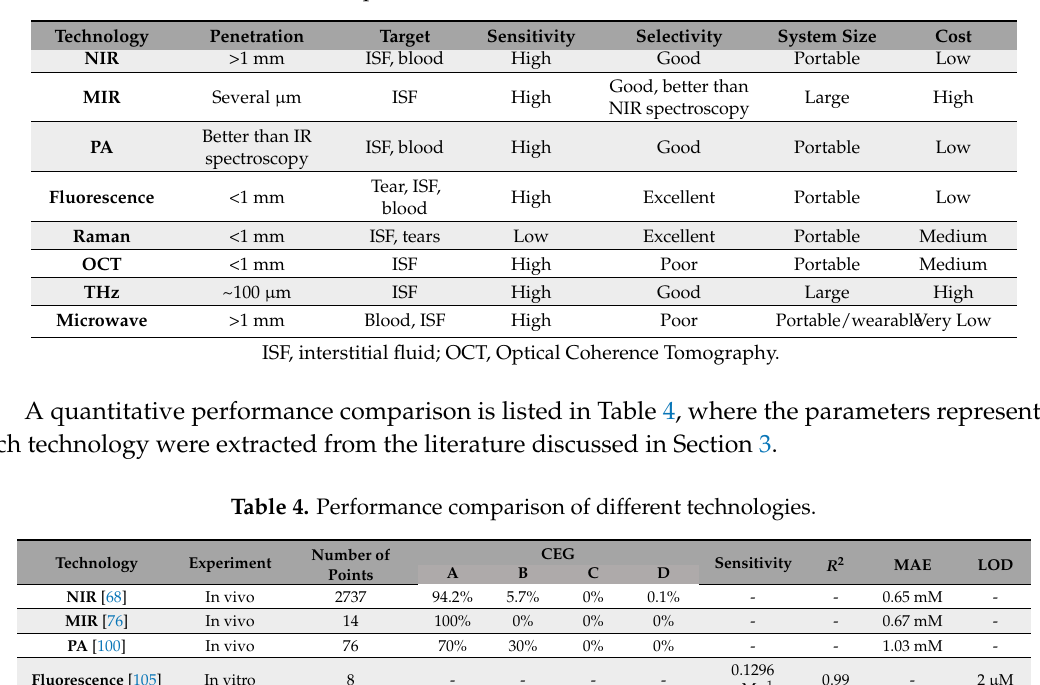
Table 3. Comparison of different EM-wave-based methods.